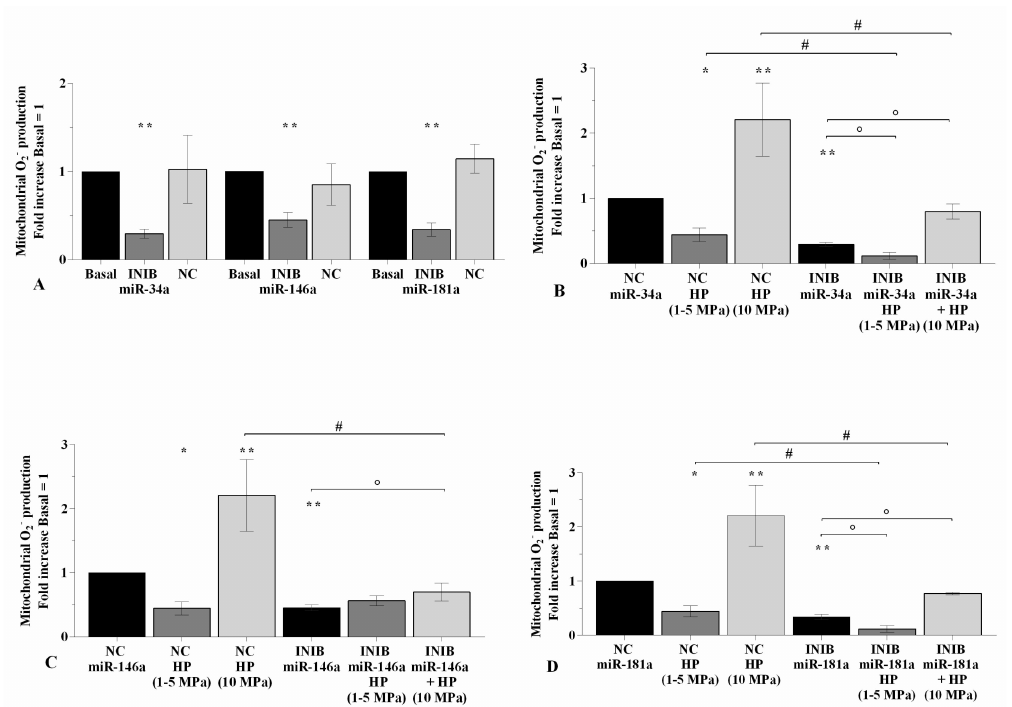
Figure 6. miRNA silencing regulates oxidative stress following HP exposure. ( A – D ) Mitochondrial superoxide anion production evaluated by MitoSox Red staining at flow cytometry. Human OA chondrocytes were evaluated at basal condition, after 24 h of transfection with miR-34a, miR-146a, and miR-181a inhibitors (50 nM) or NC (5 nM), and after 3 h of low sinusoidal (1–5 MPa) or static continuous (10 MPa) HP exposure. The production of superoxide anion was referenced to the ratio of the value of interest and the value of basal condition or NC, reported equal to 1. Data were expressed as mean ± SD of triplicate values. * p < 0.05, ** p < 0.01 versus basal condition or NC. ◦ p < 0.05 versus inhibitor. # p < 0.05 versus HP. INIB = Inhibitor, NC = negative control